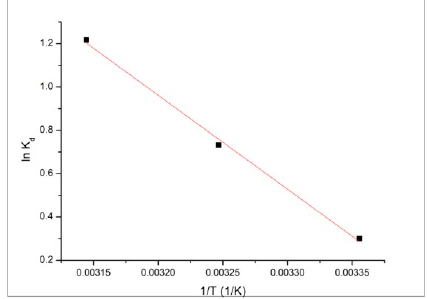
Figure 12. Adsorption isotherm of Pb 2+ onto magnetic nanocomposite MNPs35@SiO 2.